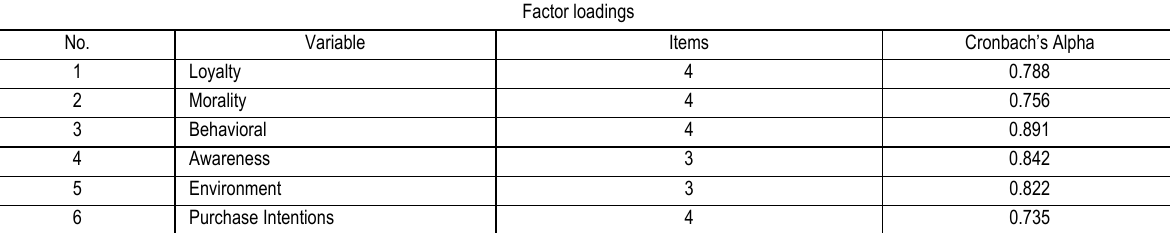
Table 2. Reliability analysis